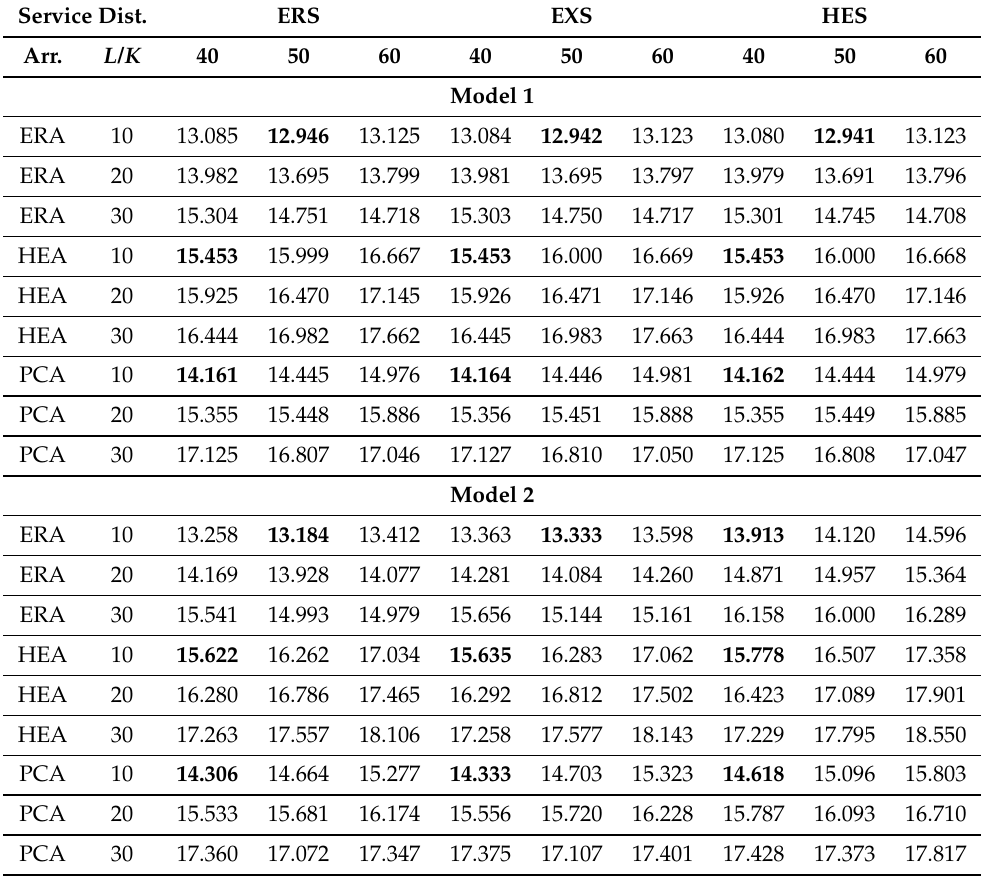
Table 4. Total cost summary γ = 0.1, µ =